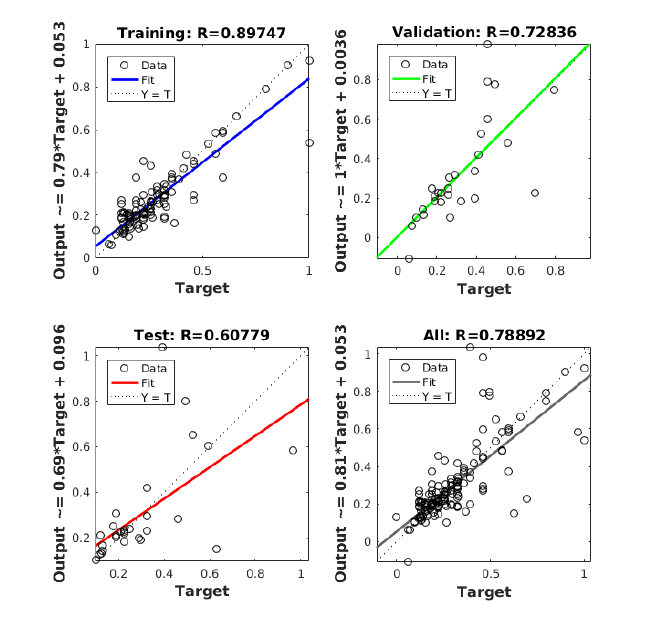
Figure 11. Regression results (target vs. predicted solution time) for one training, validation, test part of the Dice 1 dataset and for the whole dataset ( N h =